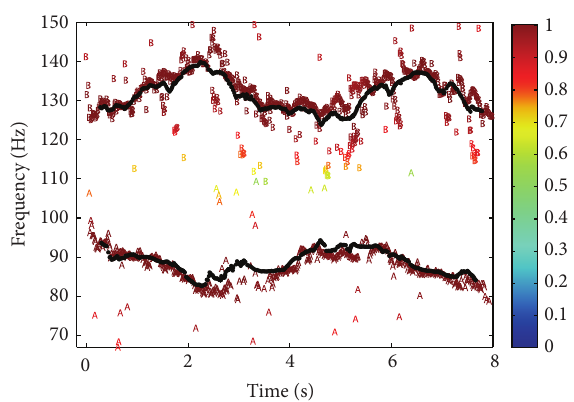
Figure 9: Recursive fuzzy clustering of the estimated modal parameters.